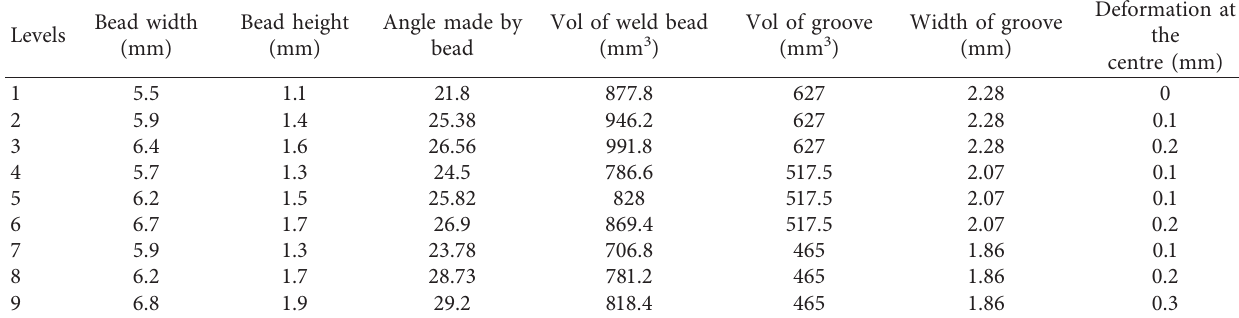
Table 8: Structural results of double V 45 ° .